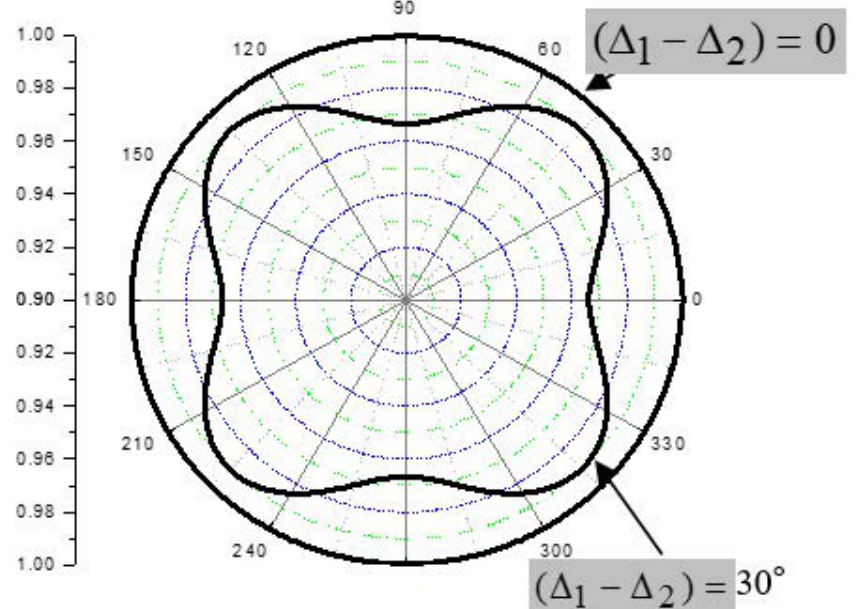
Figure 22. Amplitude response of birefringence to ≈ 60 µ m offset in +45 − 45 ◦ CFRP lay-up.